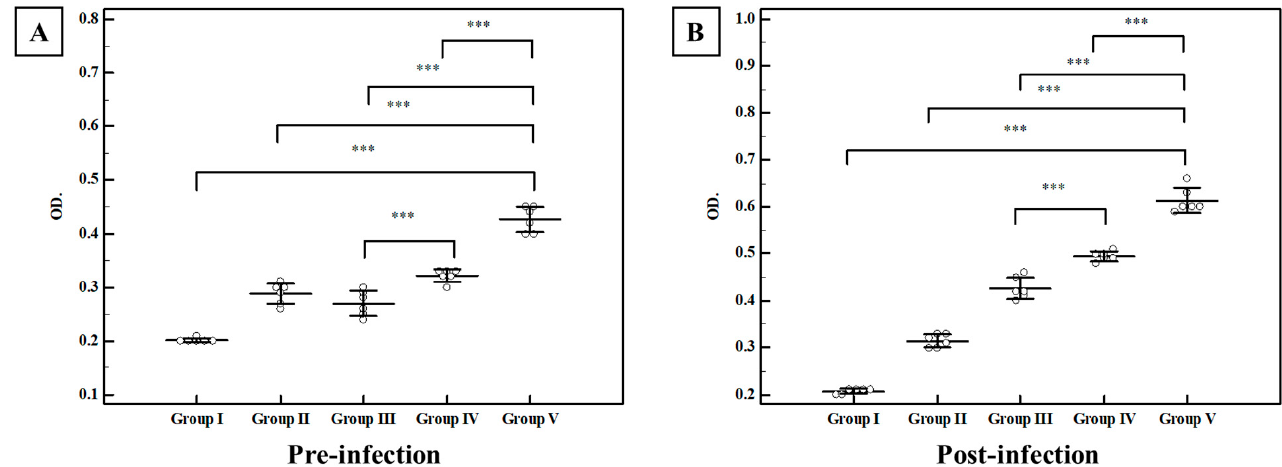
Figure 9. Pre-infection and post-infection intestinal levels of anti- Toxoplasma IgA (OD) among different studied groups. ( A ) Anti- Toxoplasma IgA antibody levels in intestinal washes of mice two weeks after completion of immunization schedules (pre-infection). ( B ) Anti- Toxoplasma IgA antibody level in intestinal washes of mice four weeks after oral challenge with Me49 Toxoplasma cysts (post-infection). Data were expressed by using Mean ± SD. ***: Statistically significant at p ≤ 0.001. Group I: